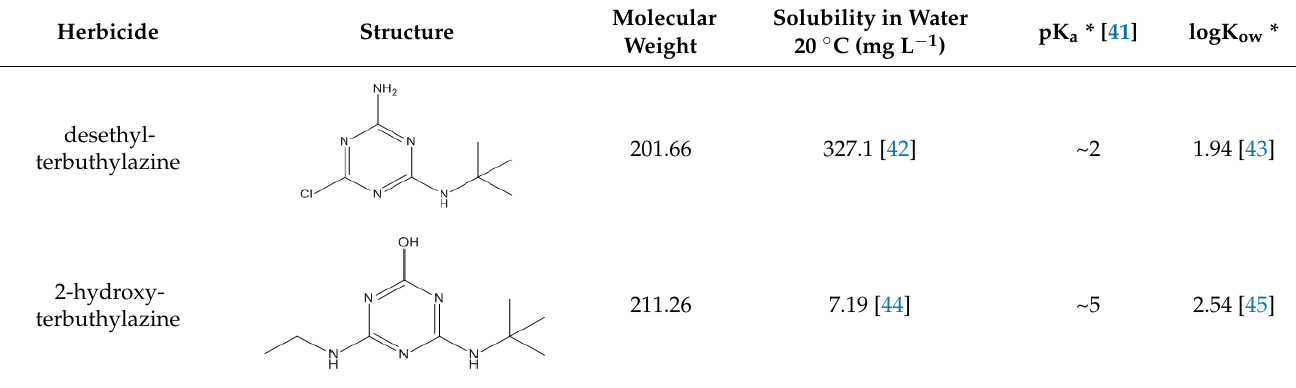
Table 1. The physicochemical properties of analyzed terbuthylazine metabolites.